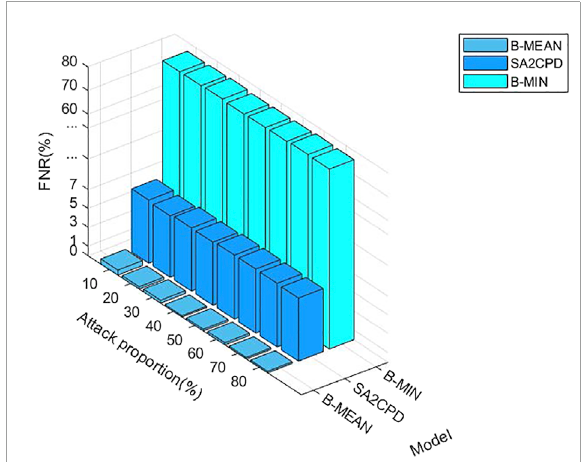
FIGURE 6 The FNR of our SA2CPD model, the B-MIN model and the B-MEAN model under different attack proportions.